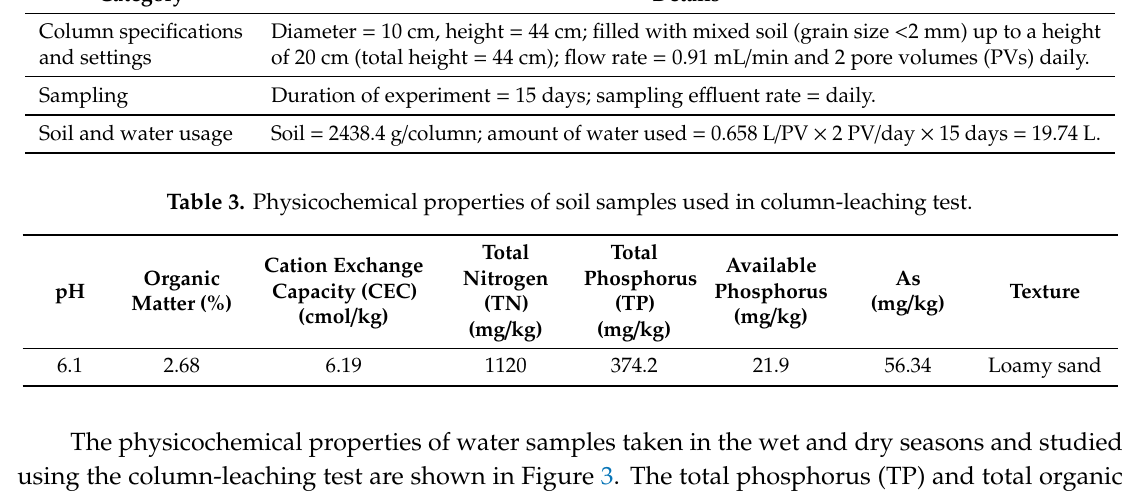
Table 2. Details of the column-leaching test.